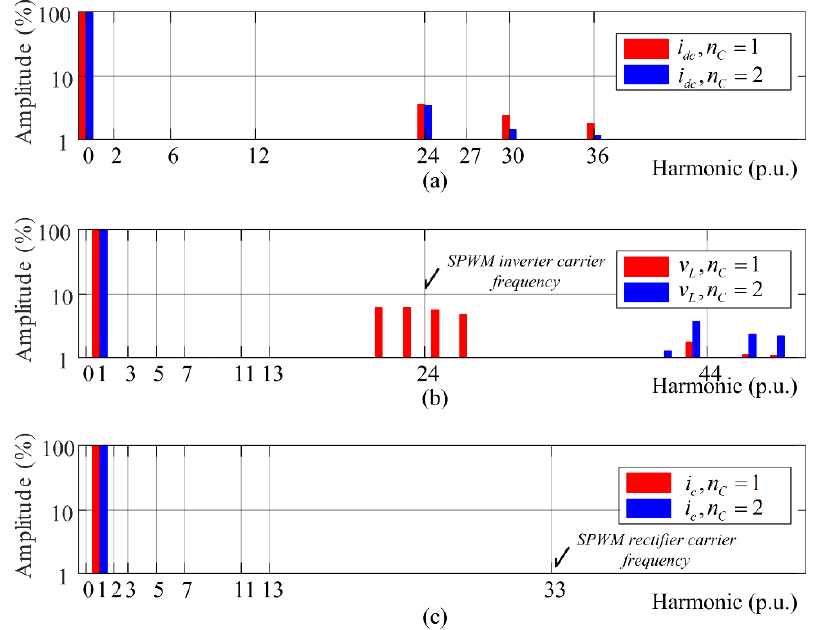
Figure 7. Spectra for steady state, per unit (p.u.) with respect to f i = 50 Hz, I dc = 50 A (using wave- forms shown in Figures 5 and 6, and highlighted with orange); ( a ) dc current for n C = 1 (THD = 5%) and n C = 2 (THD = 4.3%) (see Figure 5a); ( b ) load voltage current for n C = 1 (THD = 11.9%) and n C = 2 (THD = 5.8%) (see Figure 5c); ( c ) cell input current for n C = 1 (THD = 0%) and n C = 2 (THD = 0%) (see Figure